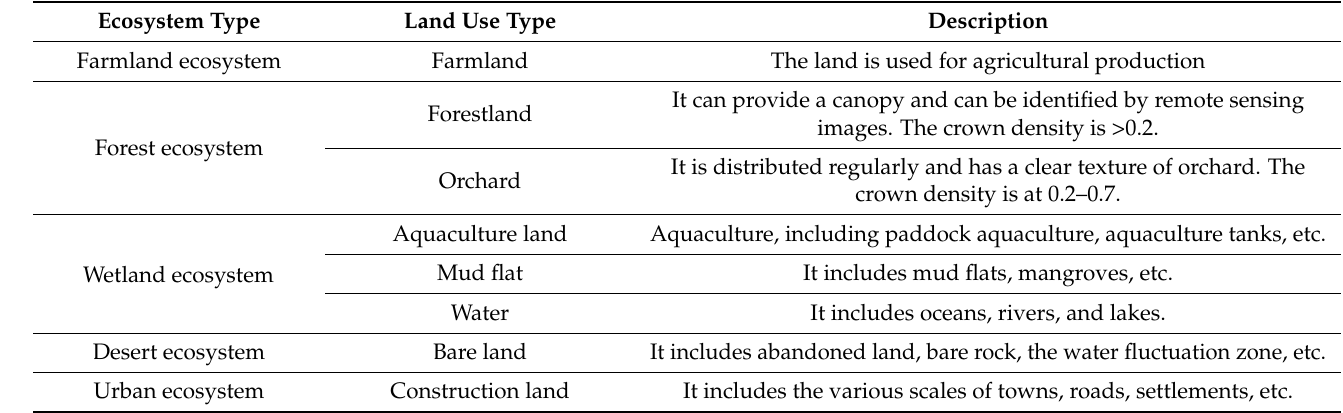
Table 2. Classification and definition of ecosystem and land use types.